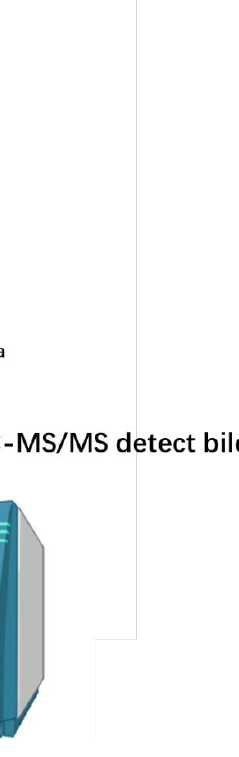
Figure 1. The workflow of the effect in bile acid supplement to high plant protein diet on common carp bile acid profile and hepatopancreas health. Arrows a: Common carp fed with HP and HP+BAs 11 weeks, respectively. Arrows b: Collect hepatopancreas, gallbladder, and plasma. Arrows c: Histopathological detections of hepatopancreas tissues. Arrows d: BAs analysis was performed on the bile and plasma corresponding to phenotype I of the hepatopancreas in the HP group ( n = 8), the gallbladder and plasma corresponding to phenotype II of HP+BAs were treated in the same way ( n = 7).